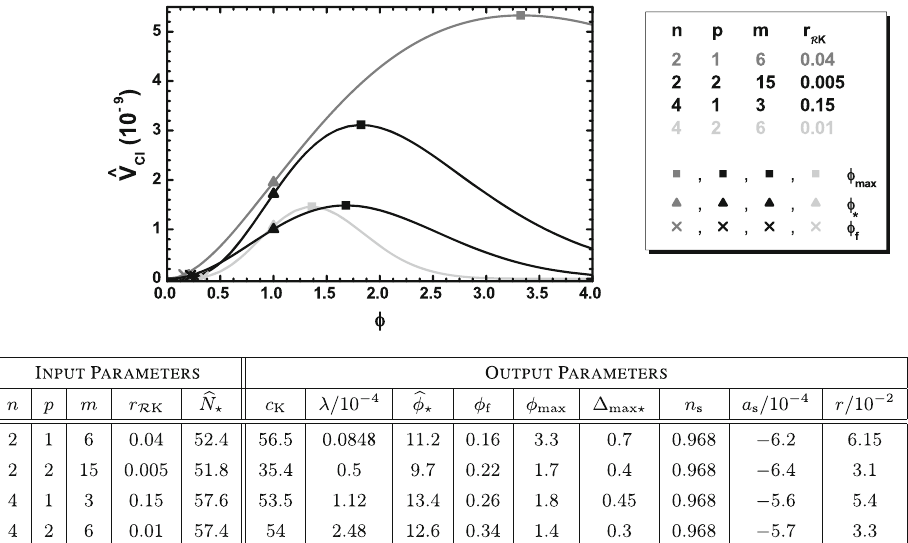
Fig. 3 The inflationary potential (cid:5) V CI as a function of φ for φ > 0 (black line), or ( n , p , m , r R K ) = ( 4 , 2 , 6 , 0 . 01 ) (light gray line). The and ( n , p , m , r R K ) = ( 2 , 1 , 6 , 0 . 04 ) (gray line), ( n , p , m , r R K ) = values of φ (cid:21) = 1, φ f and φ max are also indicated in each case and listed ( 2 , 2 , 12 , 0 . 005 ) (dark gray line), ( n , p , m , r R ) = ( 4 , 1 , 3 , 0 . 15 ) together with the corresponding inflationary observables in the K